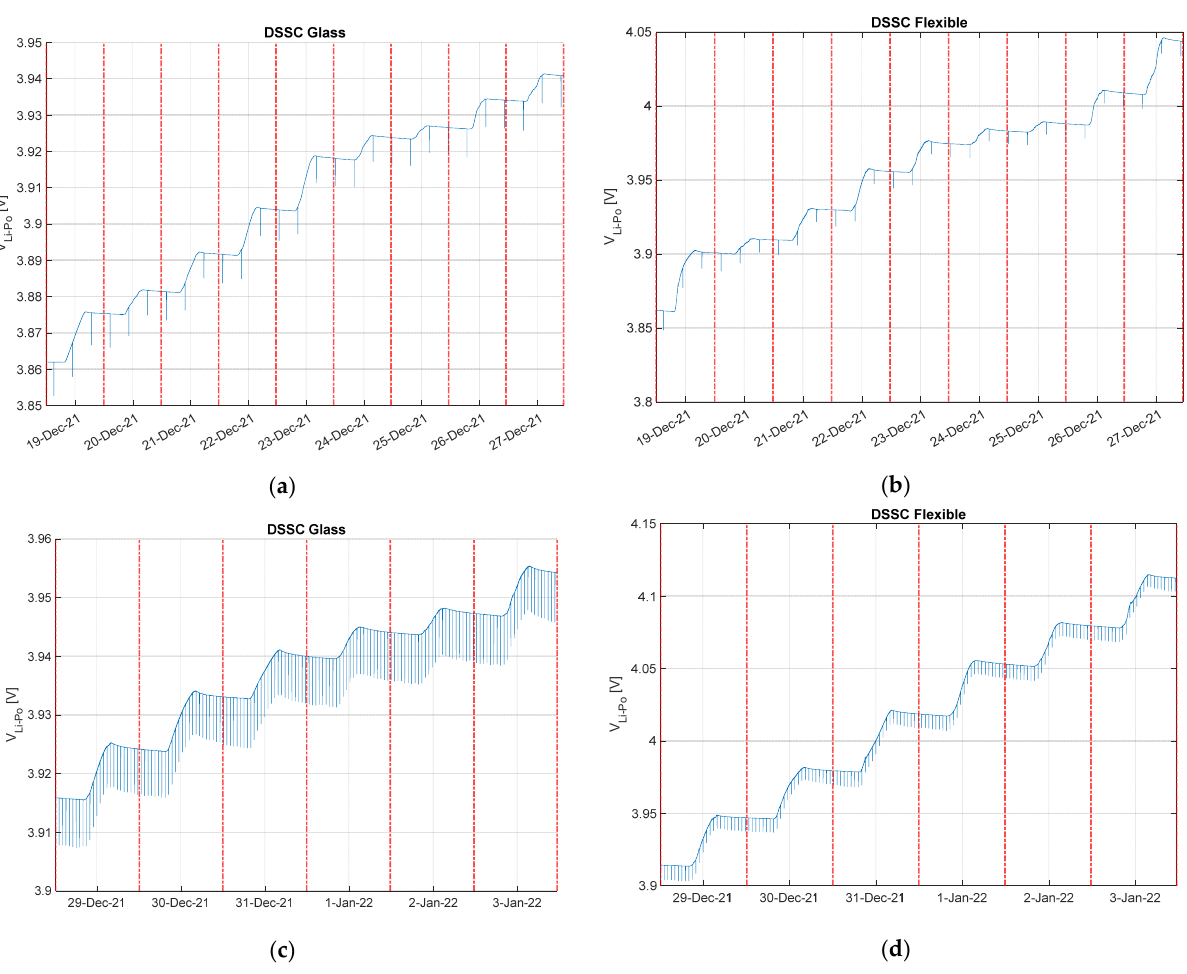
Figure 6. The acquired Li-Po battery voltages in the case of glass and flexible DSSC energy harvesting during the first test campaign (( a , b ), respectively) and the second test campaign (( c , d ), respectively).